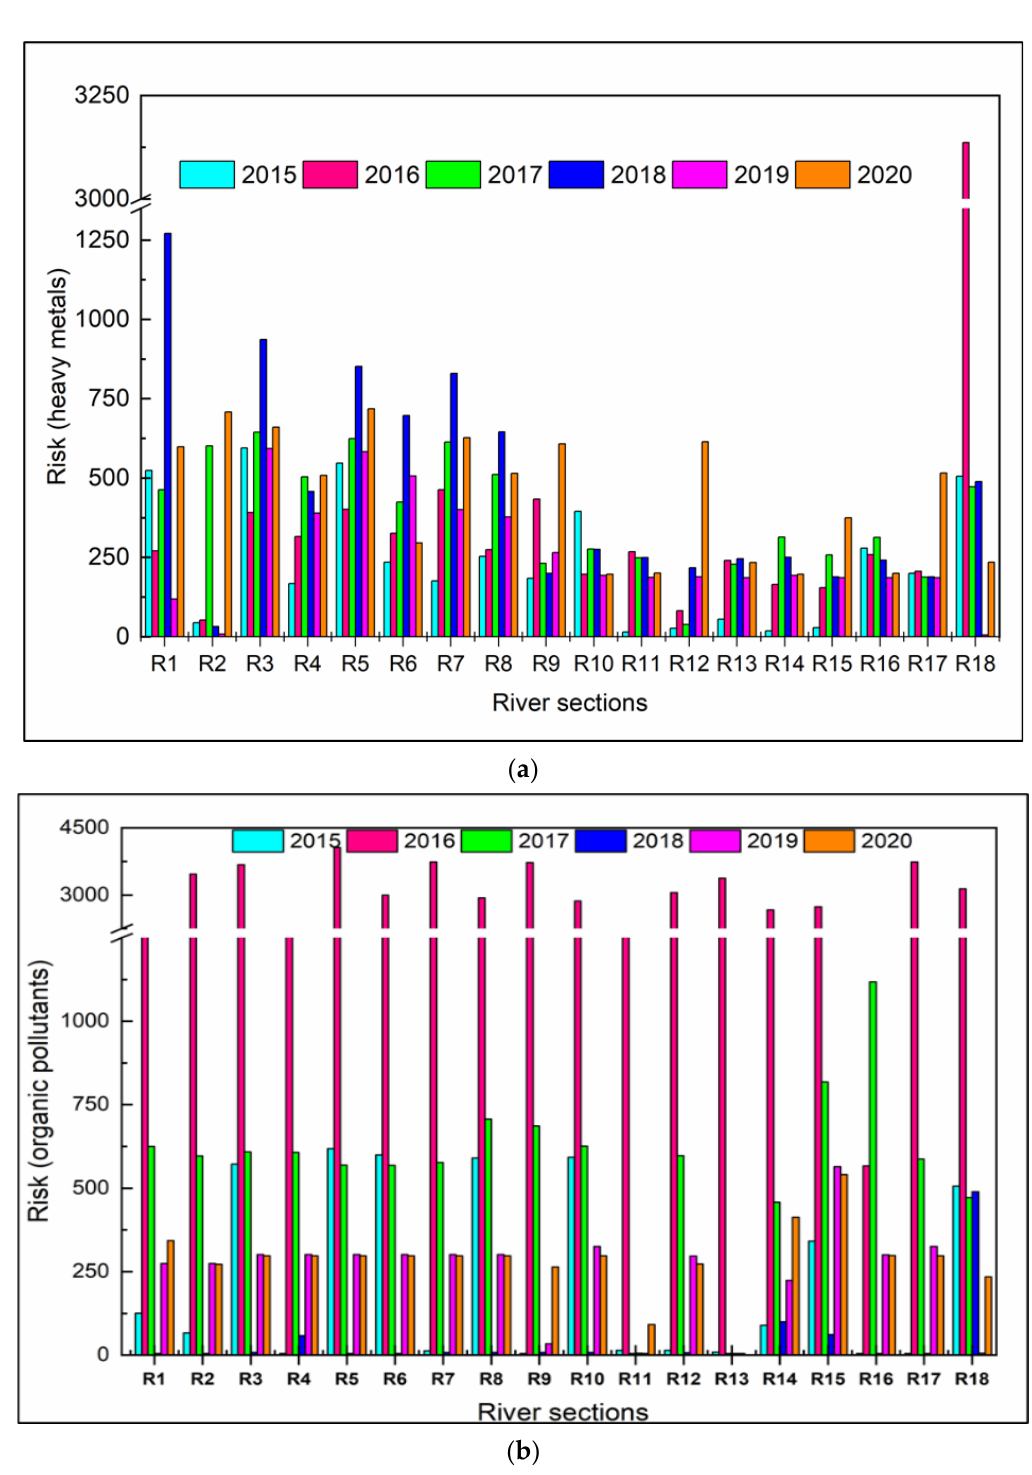
Figure 6. Environmental risks, period 2015–2022: ( a ) risk of heavy metals; ( b ) risk of organic pollu- tants.